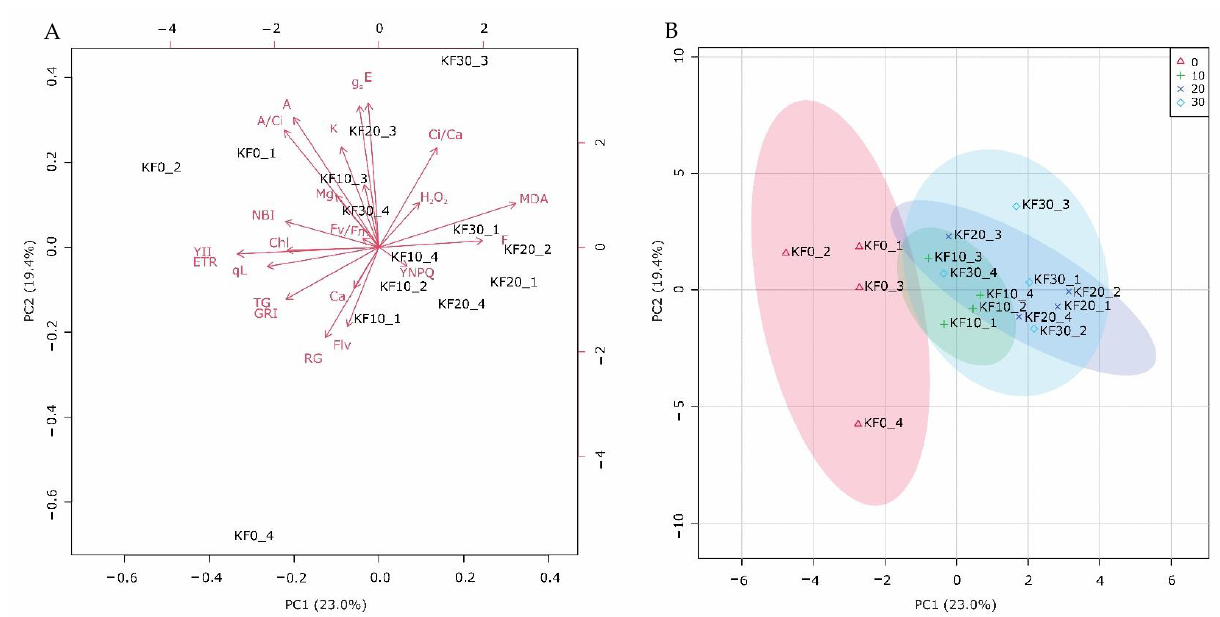
Figure 3. Principal component analysis (A) and score plot (B) for fluoride, nutrient content, physio- logical, biochemical, and morphological traits of Lactuca sativa L. plants after 7 days of exposure to 0 mg L − 1 , 10 mg L − 1 , 20 mg L − 1 , and 30 mg L − 1 potassium fluoride (KF) in the germination test and 40 days of cultivation in a greenhouse with 0 mg L − 1 , 10 mg L − 1 , 20 mg L − 1 , and 30 mg L − 1 KF treatments.